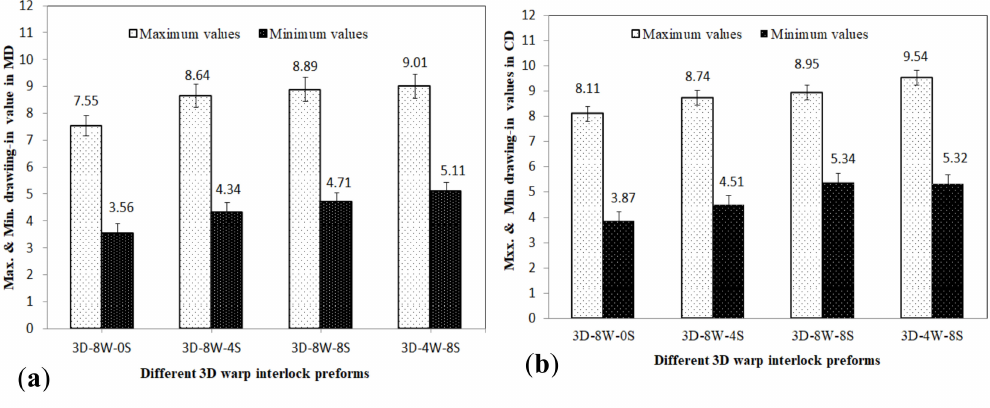
Figure 13. The maximum and minimum drawing-in values of 3D warp interlock preforms in machine (MD) ( a ) and cross (CD) ( b )